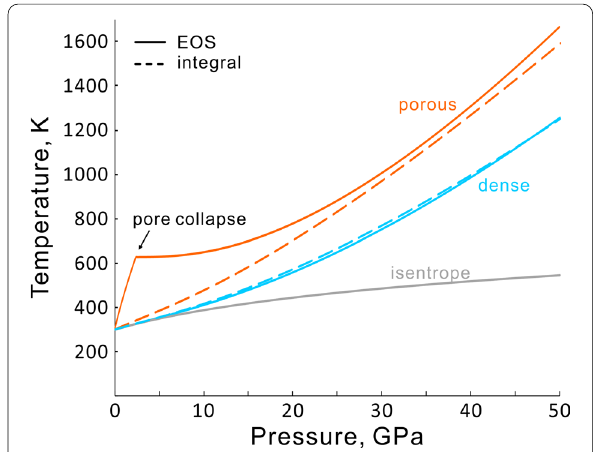
Fig. 2 The shock temperature versus pressure for porous and dense L chondrite, calculated by the equation of state (EOS) and integral approximation, using the Hugoniot data in Table